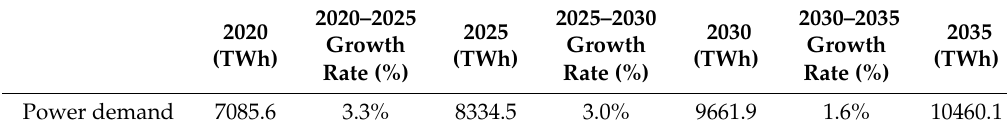
Table 4. Prediction of the total power demand between 2019 and